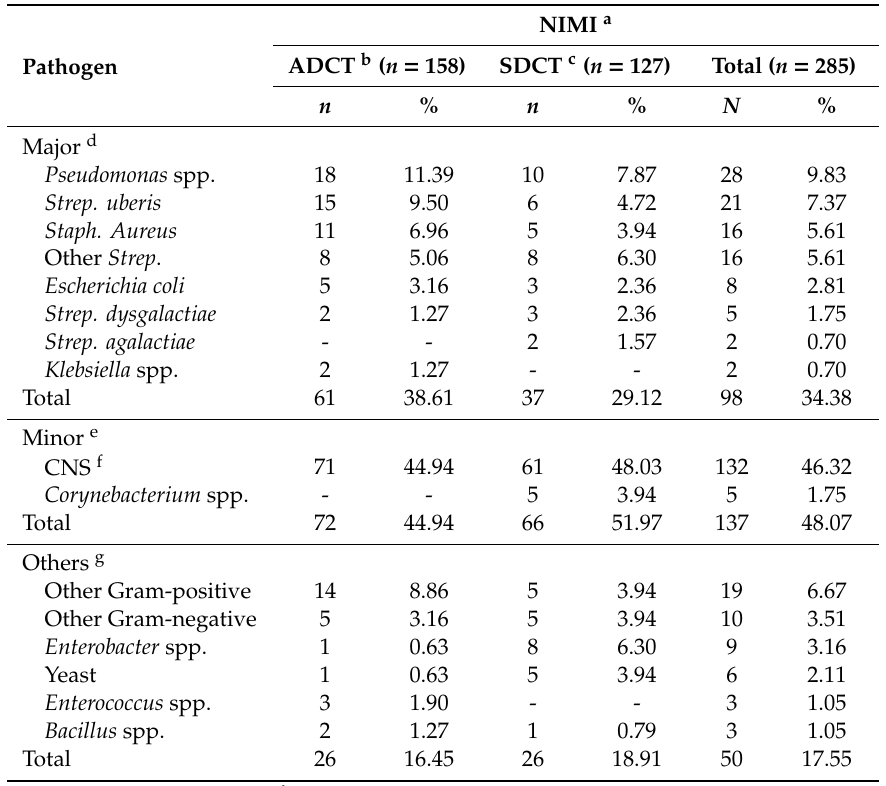
Table 7. Frequency of bovine mastitis pathogens isolated from NIMI cases (considering two postpartum samples) according to drying o ff